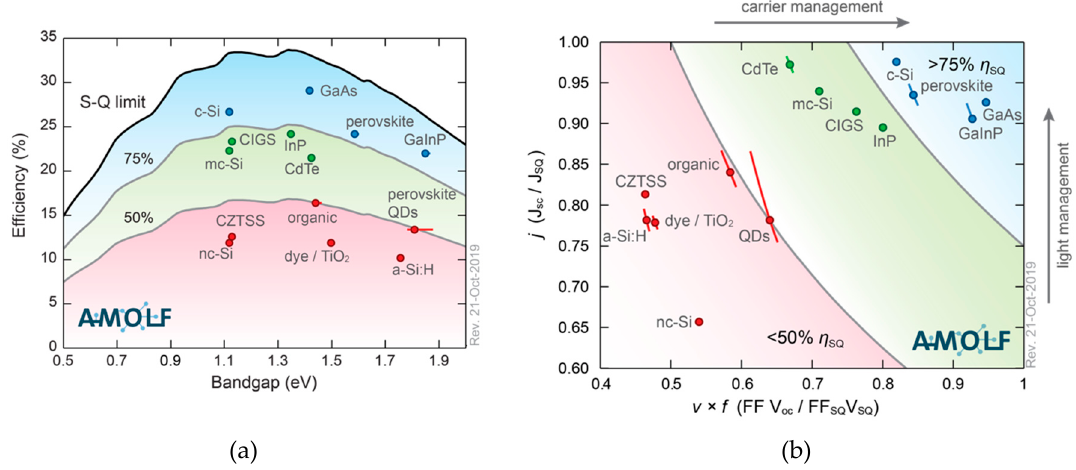
Figure 4. Record-efficiency cell parameters compared to the detailed-balance limit. ( a ) Blue dots show materials that are closer to the Shockley–Queisser (SQ) detailed-balance limit (black line). Green and red dots (area) show the materials that are performing less good. ( b ) SQ-normalized current vs. normalized voltage (× fill factor) indicates in which aspects materials could be improved: CdTe is close to the current limit, but loses out on voltage (which can be optimized by charge carrier management). GaInP gives an excellent voltage, but needs better light management (converting photons into electrons/current) to be improved. Reproduced with permission from Science 2016 , 352 , aad4424. Updated graphs, taken from the website related to Reference [10].